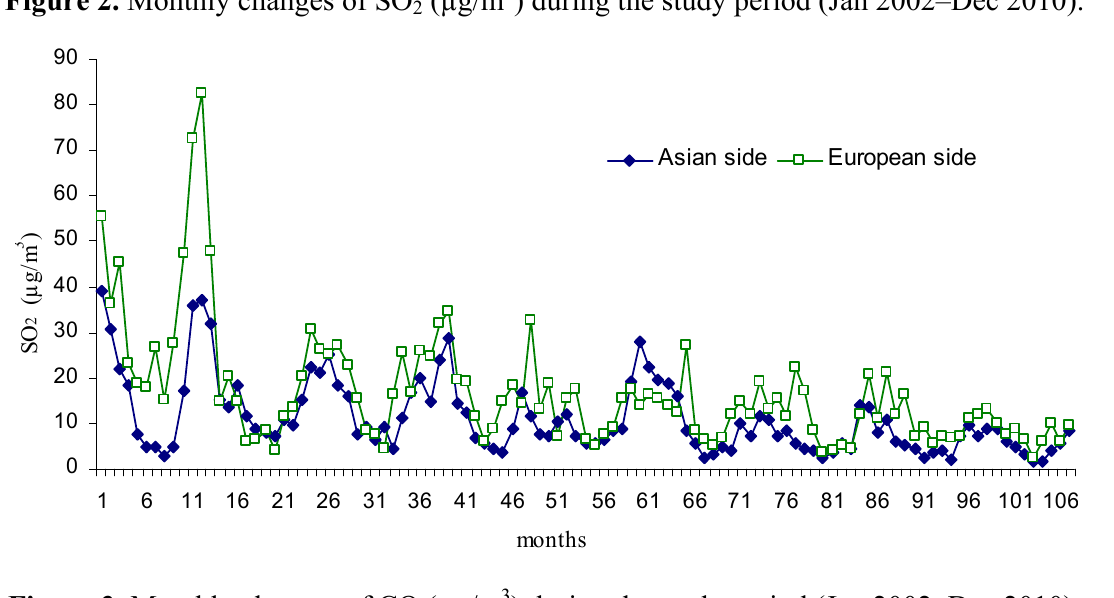
Figure 2. Monthly changes of SO